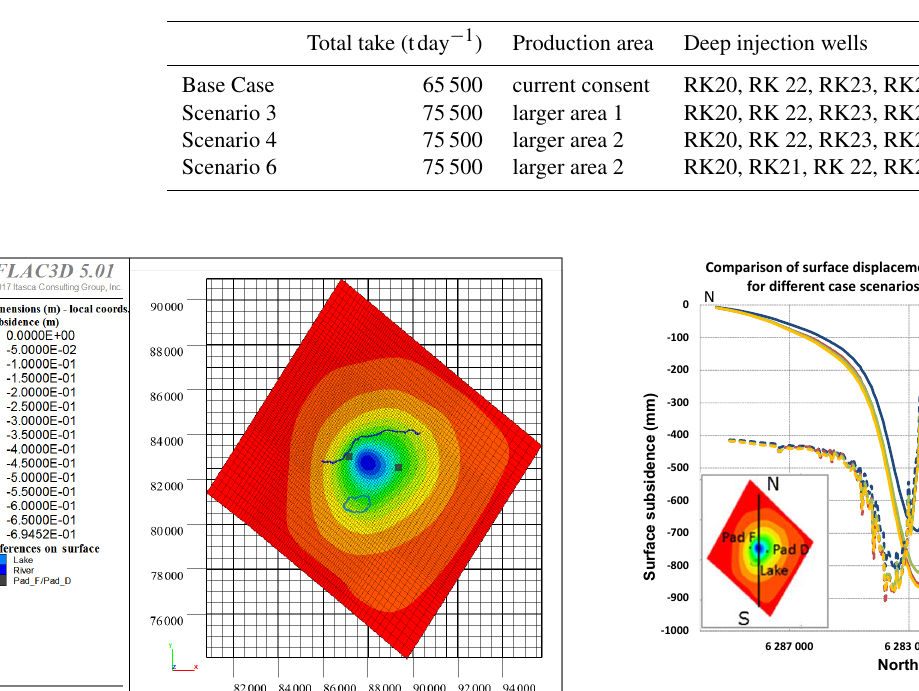
the higher density of cooler water.